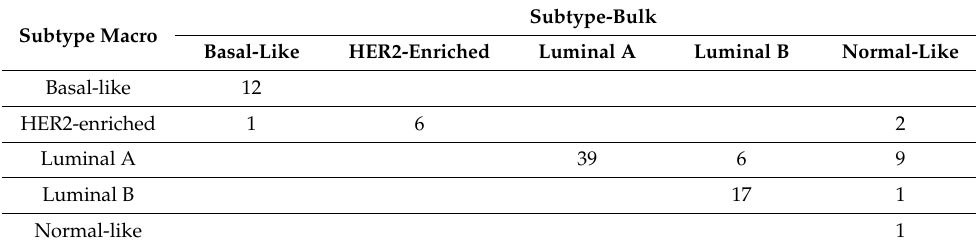
Table 3. Comparison of subtype calls using Subtype-Bulk and Subtype-Macro: subtypes based on gene expression obtained from fresh-frozen bulk tumor biopsies are shown in columns, and subtypes based on gene expression obtained from macrodissected FFPE sections are shown in